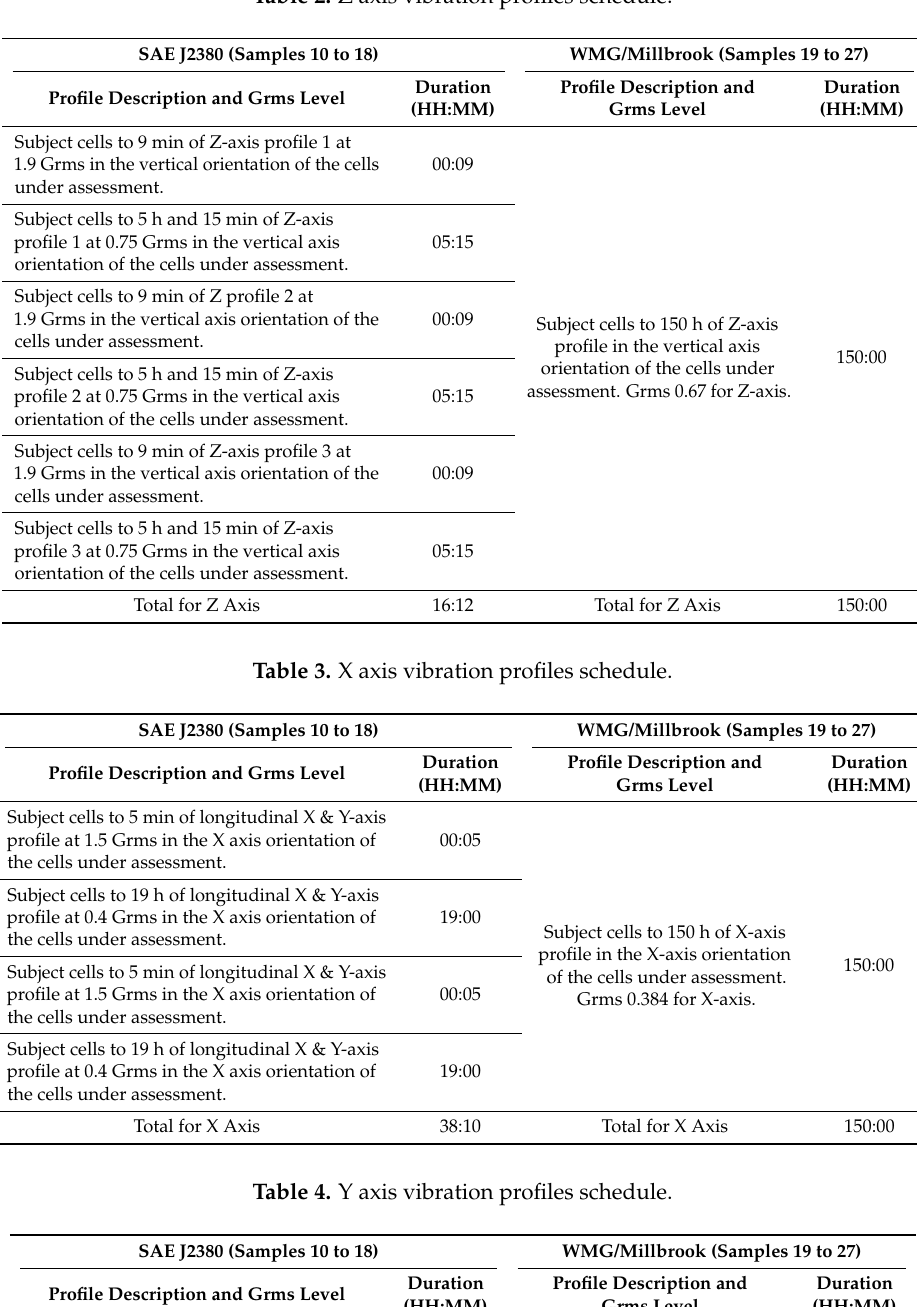
Table 2. Z axis vibration profiles schedule.